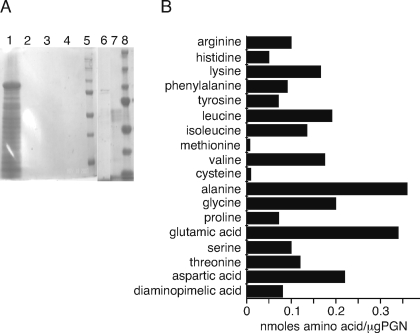
Purified peptidoglycan from B. anthracis lacks noncovalently bound proteins.(A) Silver-stained SDS PAGE showing with samples from purification steps and comparison to commercial preparation. Lane 1: bacteria after harvest, lane 2: equivalent sample of extracted PGN, lane 3: molecular weight marker. (B) Amino acid content of B. anthracis PGN.